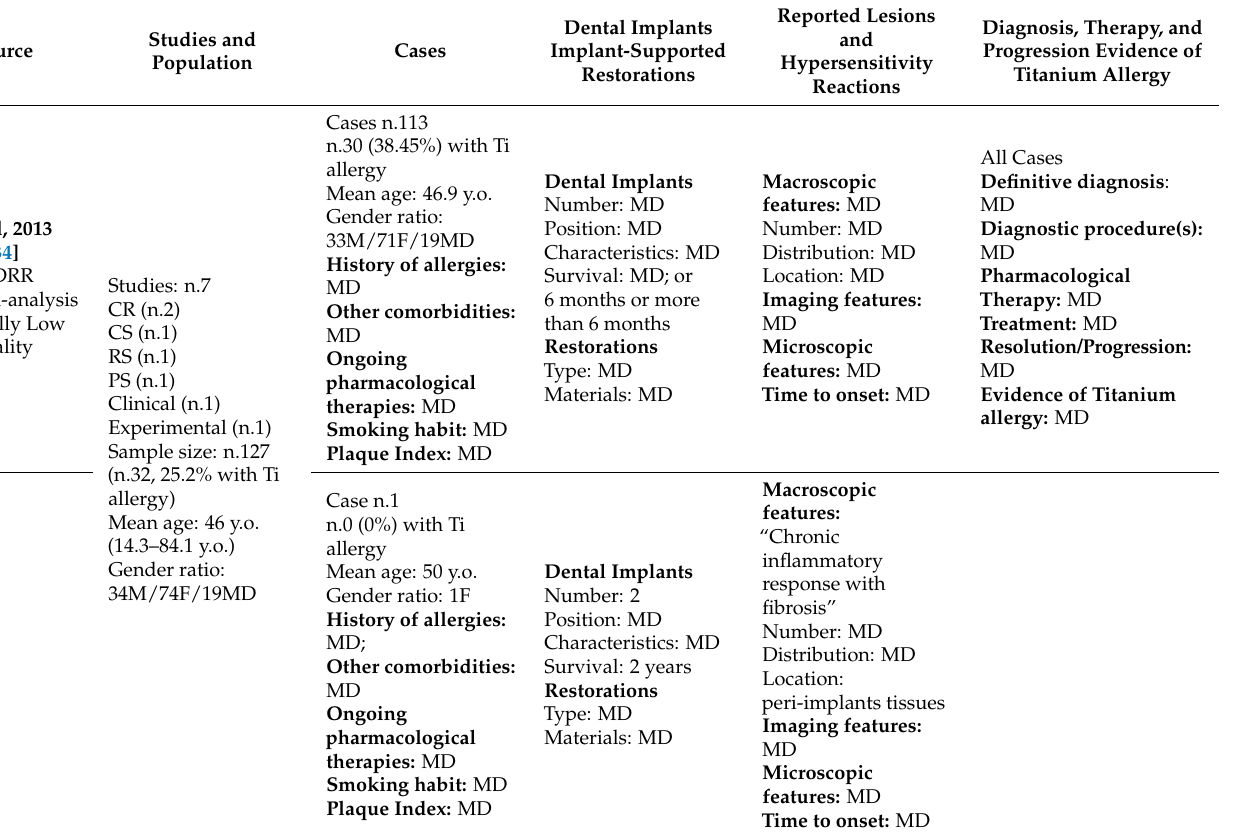
Table 1. Data extracted and collected from the studies included in the present systematic review. Source: First Author, year, reference, journal of publication, meta-analysis, assessed quality, and funding (if any). Studies of the systematic reviews included in the present umbrella review: